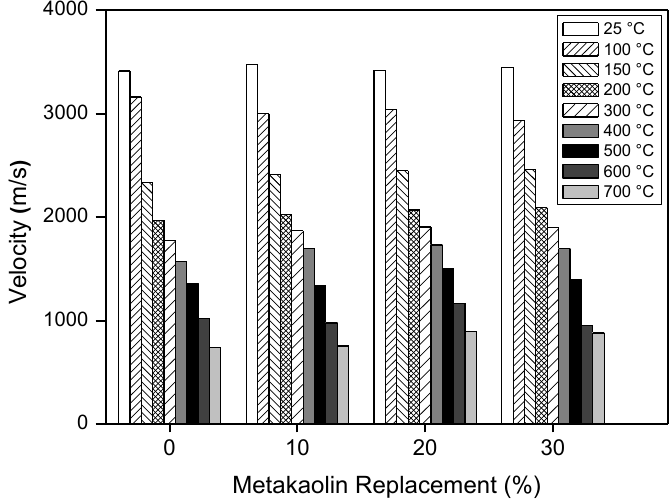
Figure 9. Propagation velocities of ultrasonic pulse vs temperature at different FBA contents.